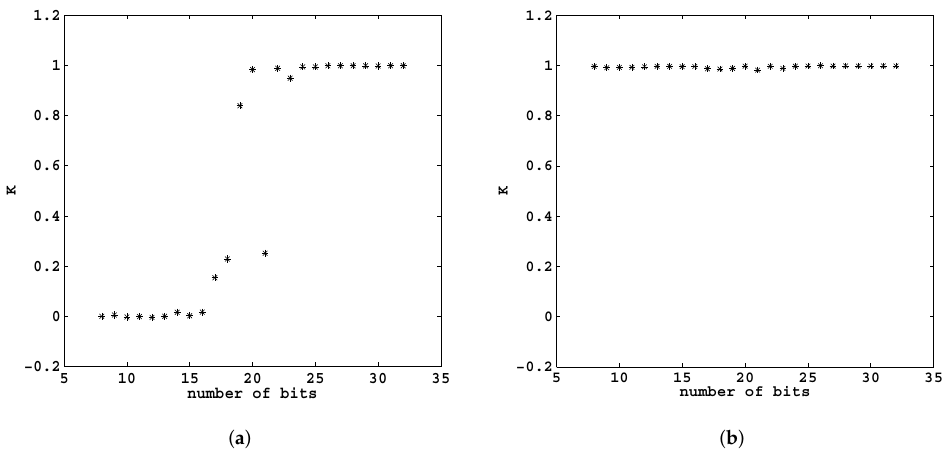
Figure 5. The 0-1 test results ( K values) for various numbers of bits between 8 and 32 (horizontal axis): ( a ) sequence of 7th bits from the logistic map only with µ = 3.99, ( b ) same as in part ( a ) but the sequence of 7th bits from the logistic map was XORed with the bits resulting from the continuous Chua (Matsumoto) circuit.